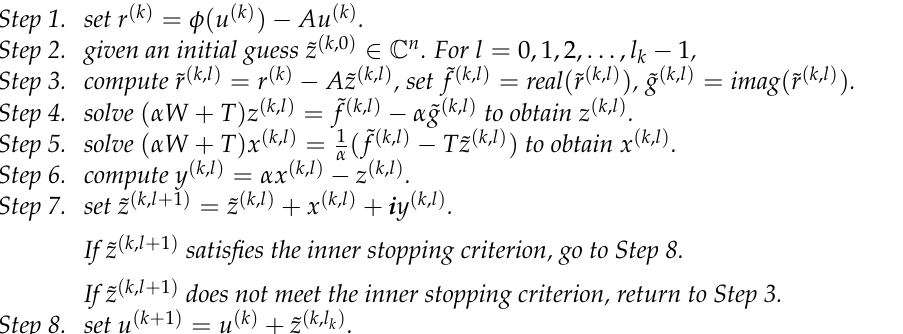
, use the following iteration steps to k = 0